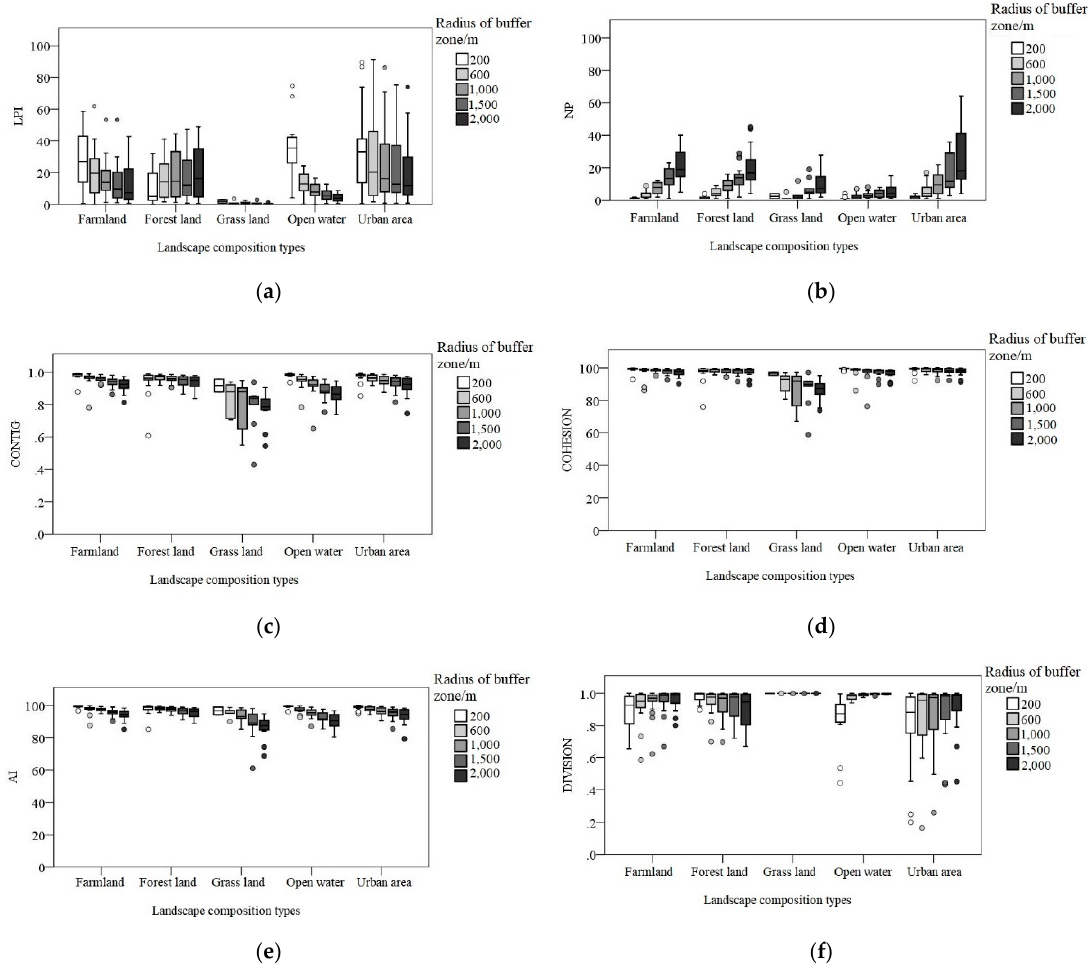
Figure 5. Statistics of landscape indices in buffer zone with different radiuses: ( a ) Largest path index ( LPI ), ( b ) number of patches ( NP ), ( c ) contiguity index ( CONTIG ), ( d ) patch cohesion index ( COHESION ), ( e ) aggregation index ( AI ), and ( f ) landscape division index ( DIVISION ) values of different landscape composition types.